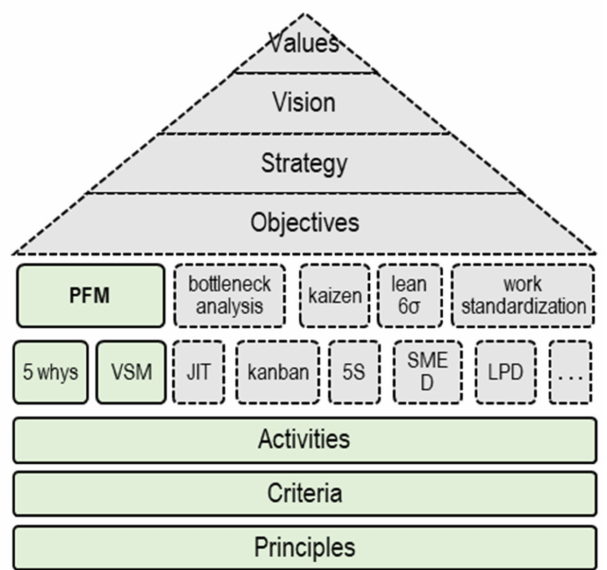
Figure 8. The proposed model is the base to achieve the organizational mission by lean tools enablers. The principles and the assessment tool allow the definition of improvement activities. Light green items have been developed in this work, including the new (bold) PFM lean tool, while grey and dotted areas can be addressed in future